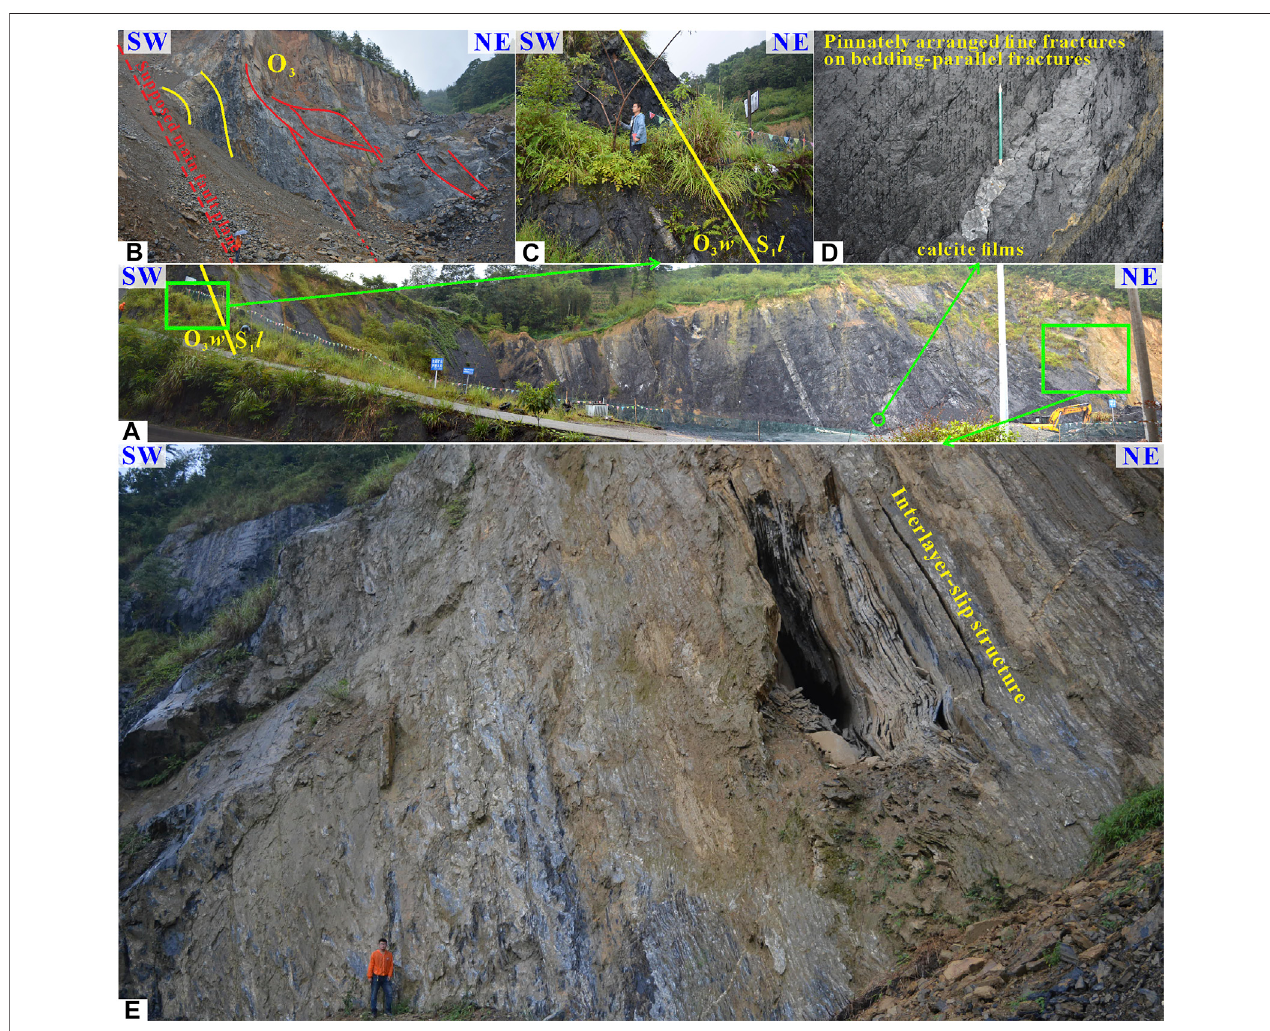
FIGURE 4 | Structural deformation characteristics of different sections of the Wufeng – Longmaxi Formation (observation point G1106). Notes: (A) a panorama of theWufeng(O 3 w )andLongmaxiFormation(S 1 l ); (B) secondarystrikereversefaultsandinterlayerfoldsintheMiddleandUpperOrdovician(O 2 – 3 )limestone; (C) theO 3 w Formation and the Lower member of the S 1 l Formation; (D) bedding-parallel fractures in the Middle member of the S 1 l Formation; (E) interlayer-slip structures in the Upper member of the S 1 l